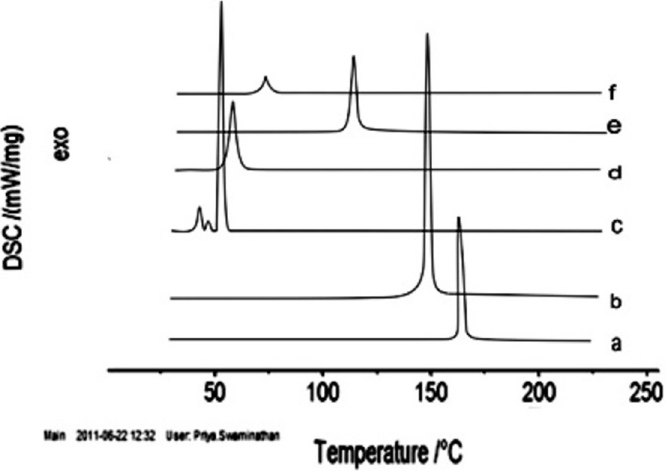
Fig 6. DSC thermograms of (a) pure drug CLB, (b) cholesterol, (c) DSPC, (d) PE-PEG, (e) CLB loaded liposomes, and (f) CLB unloaded